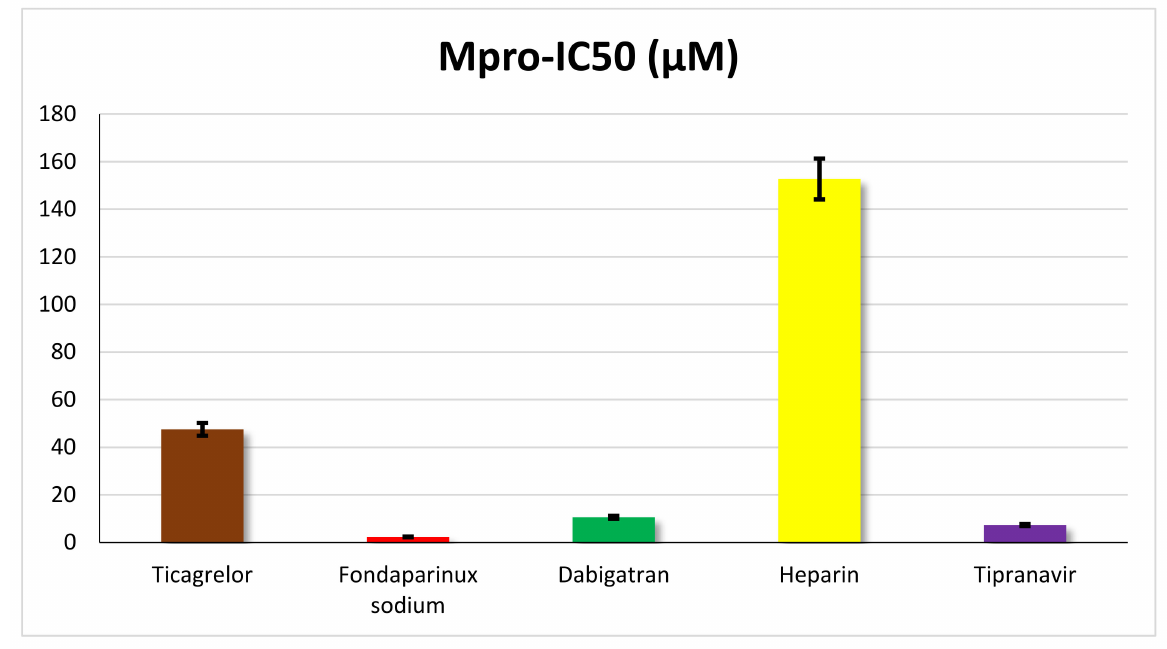
Figure 10. IC 50 values for the outstanding anticoagulant candidates (ticagrelor, fondaparinux sodium, dabigatran, and heparin) towards the SARS-CoV-2 M pro enzyme using tipranavir as a reference standard (triplicate for each